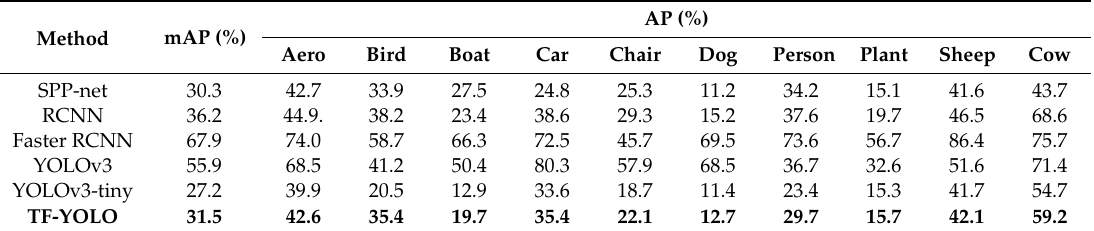
Table 3. Small objects detection results for region-based proposal methods on VOC 2007